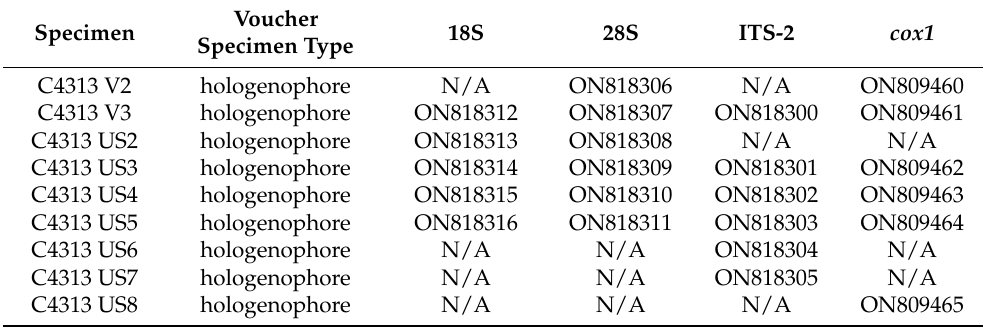
Table 1. List of tardigrade specimens utilized for molecular analyses. N/A = not